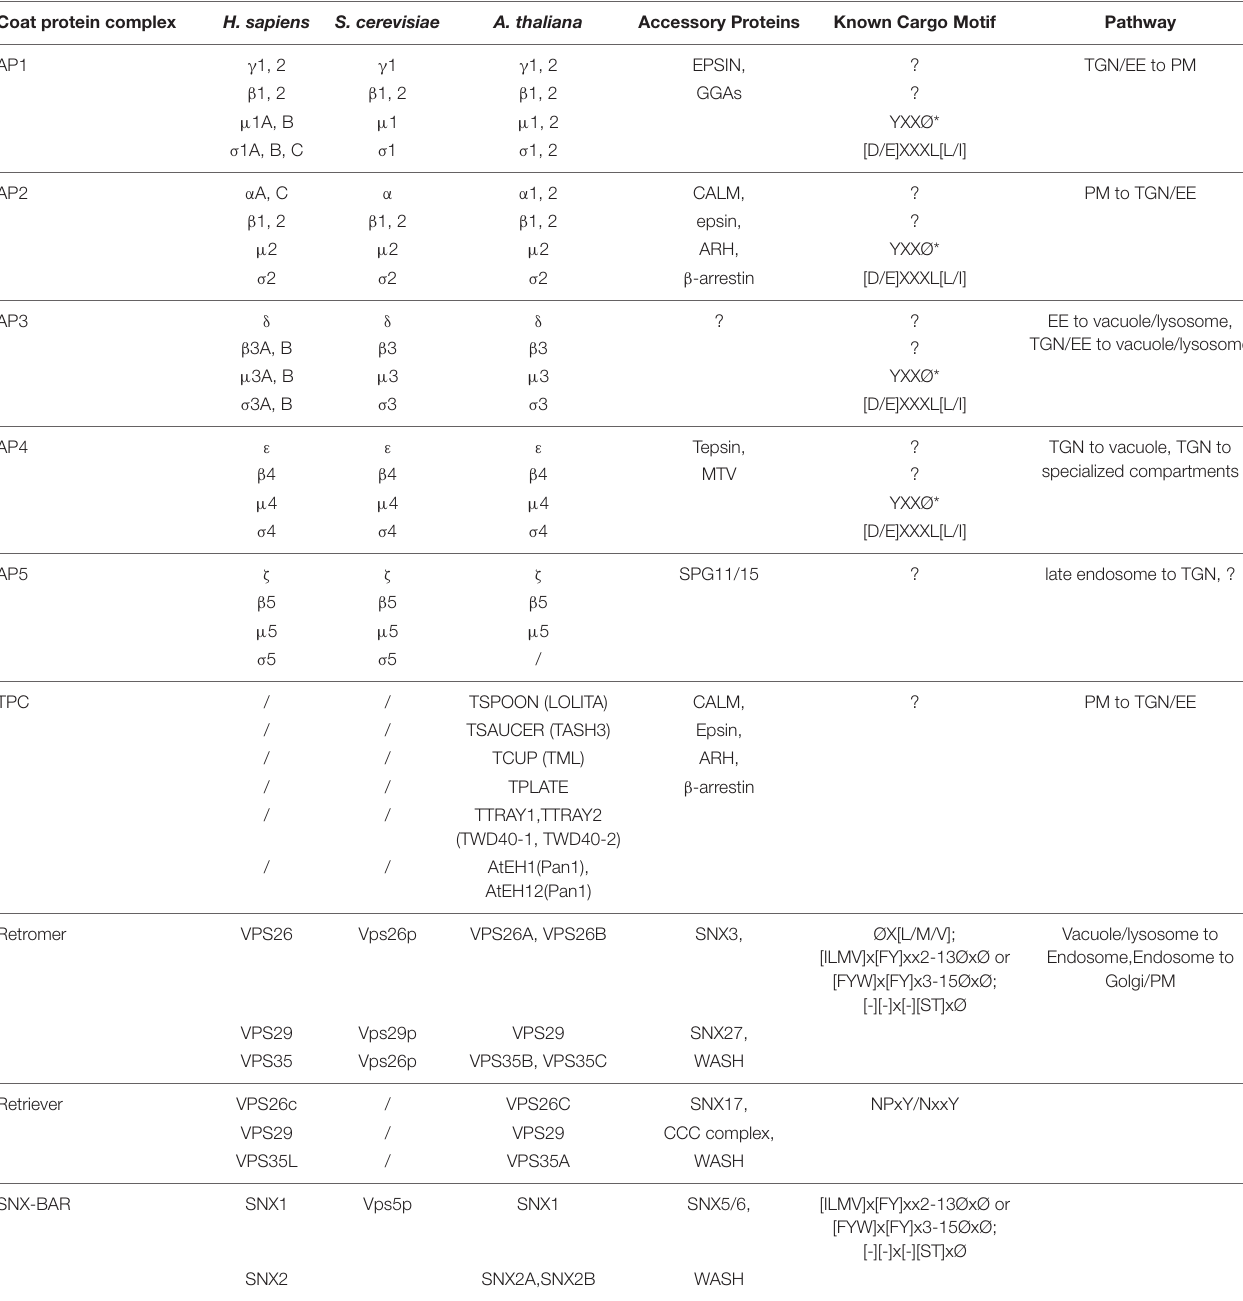
TABLE 1 | A list of the core coat protein complexes in plant post-Golgi trafficking. Coat protein